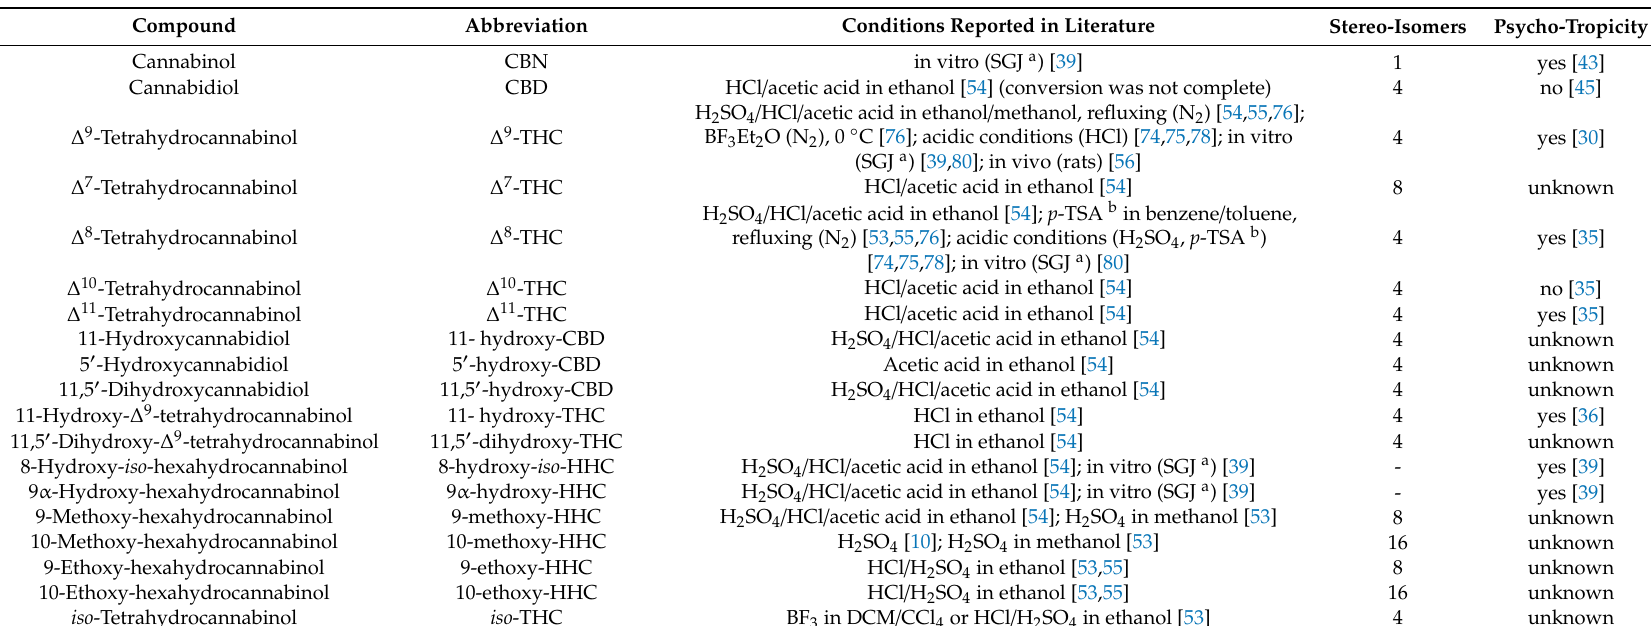
Table A1. Overview of products formed upon acid-catalyzed degradation of